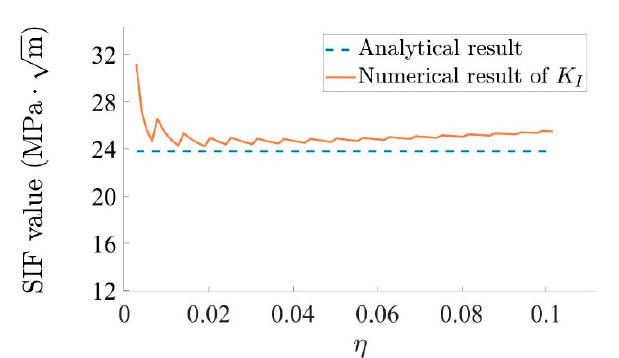
Figure 14. Comparison of numerical and analytical results for K I .